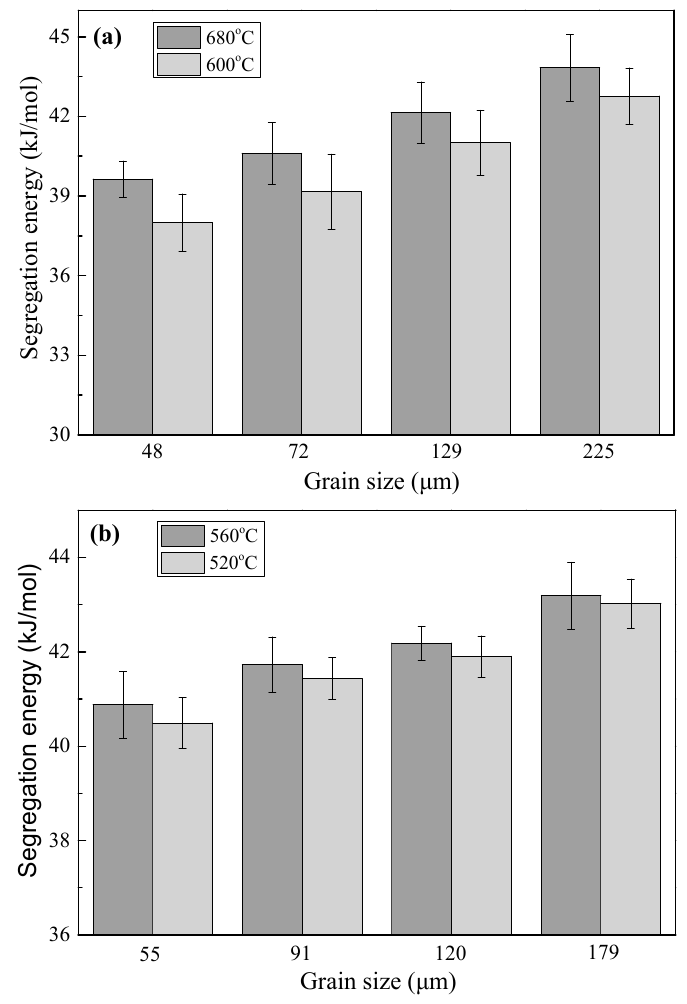
Figure 5. Free energies of segregation of phosphorus for: ( a ) IF steel; and ( b ) 2.25Cr1-Mo steel with different grain sizes (error bars represent the 95% confidence interval).